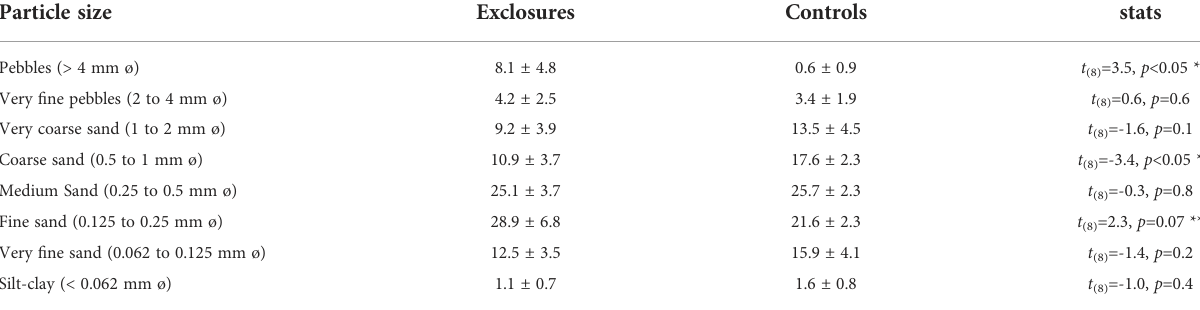
TABLE 4 Sediment grain size per particle size (%) within exclosures and control plots following 13 months of megaherbivore exclusion at Cahuita National Park, Costa